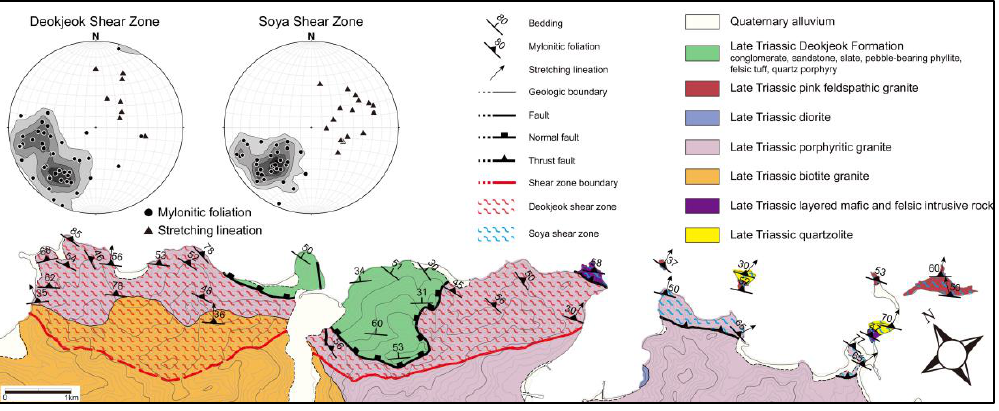
Figure 3. Detailed structural map of the northeastern coast of the Deokjeok and Soya islands. Equal-area stereograms indicate poles to mylonitic foliation and stretching lineation in the Deokjeok and Soya shear zones.